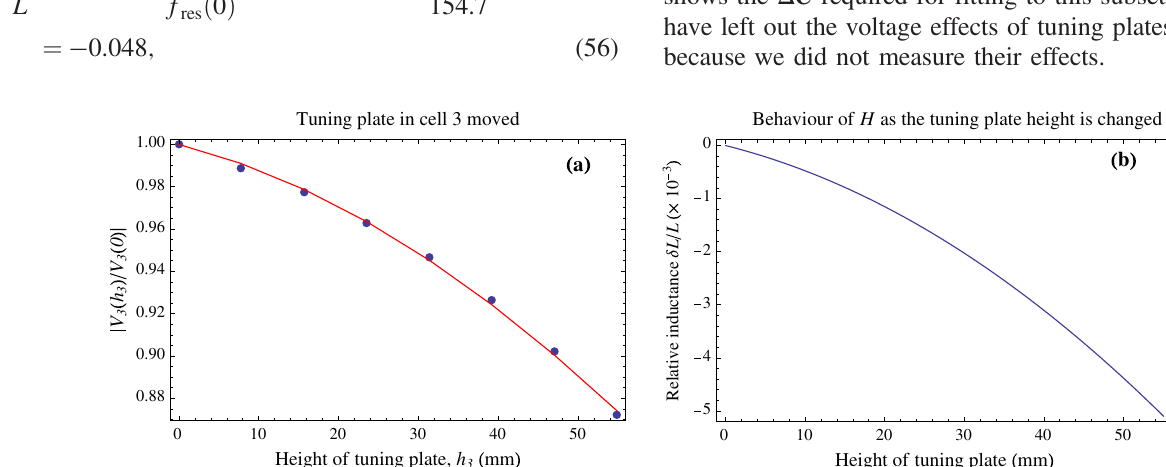
FIG. 11 (color online). (a) The red curve is the result of fitting the model to the MWS data (blue filled dots) when tuning plate 3 is moved. Part (b) is the corresponding δ L=L found from the fit. See